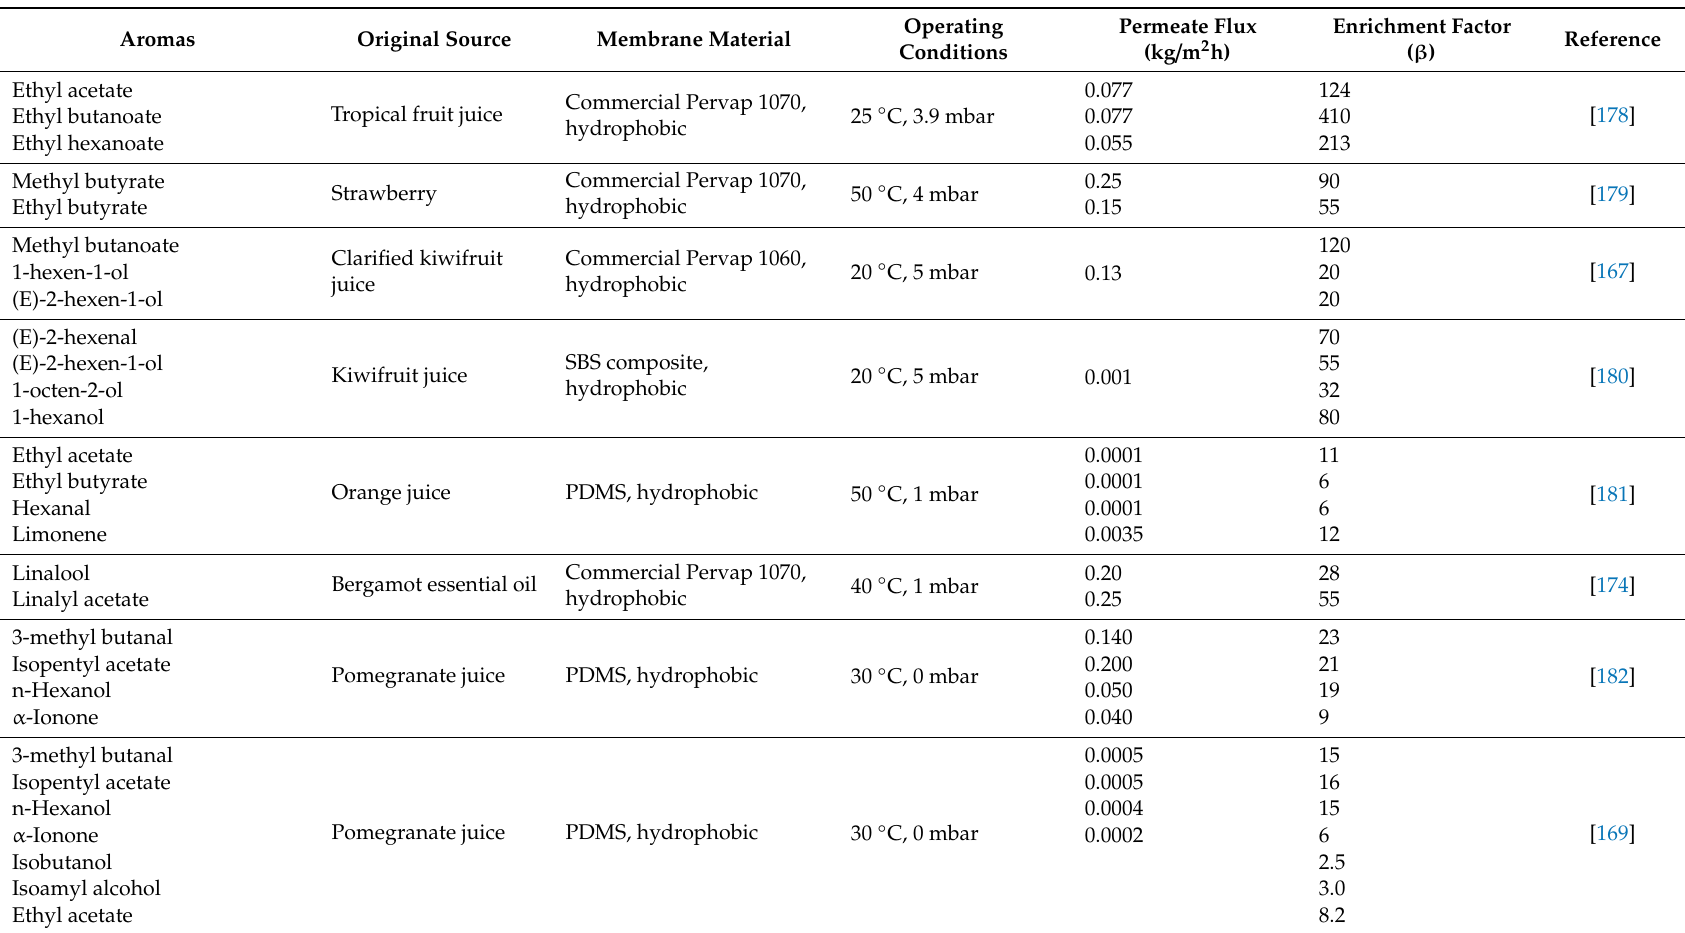
Table 6. Recovery of aromas and fruit juice processing via PV